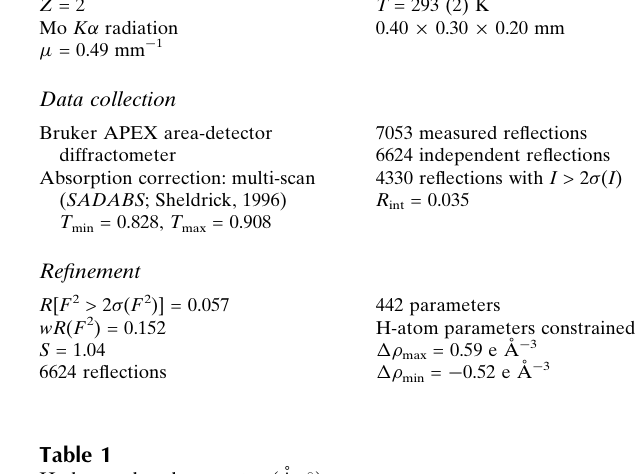
Hydrogen-bond geometry (A˚ , (cid:2)